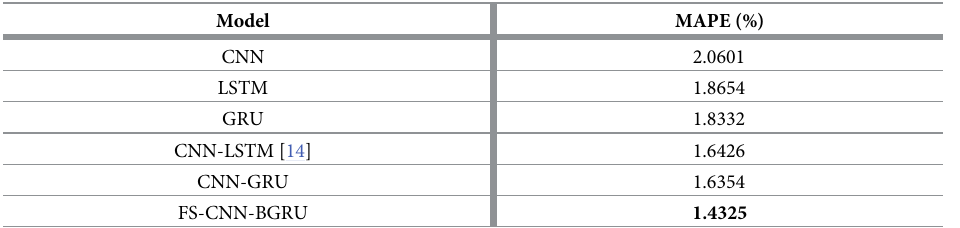
Table 9. MAPE values of different methods (%).